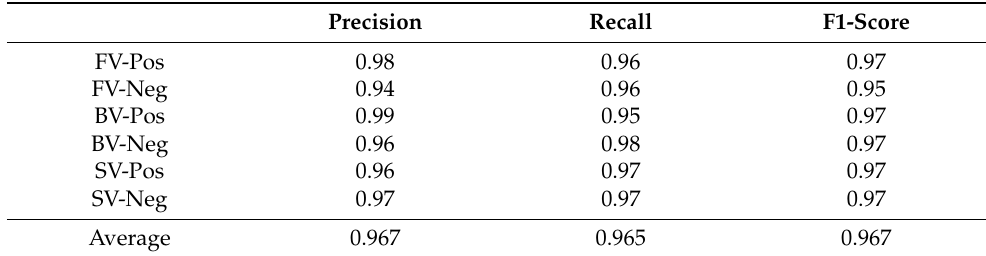
Table 16. Precision, recall, and F1-score for INRIA and MSMT17 datasets.